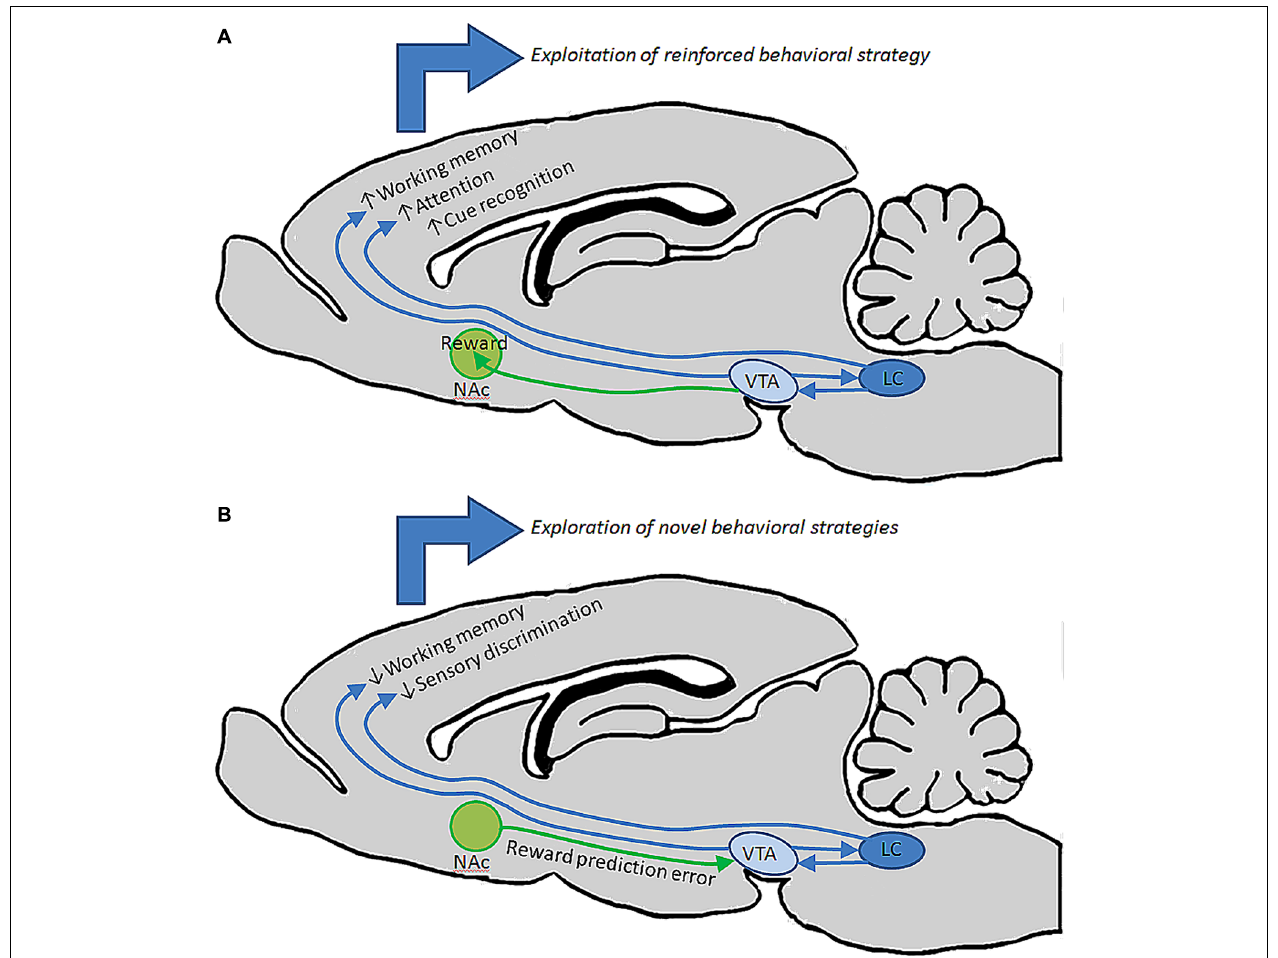
behavior until reward is retrieved. (B) When a previously successful behavioral strategy loses its relevance, NAc may signal toVTA that an expected reward has not occurred. Changes inVTA output could then alter LC output, collectively changing the level of DA and NE release in PFC to diminish working memory and discrimination of specific stimuli, instead allowing the animal to explore new behavioral strategies on the basis of detecting previously irrelevant